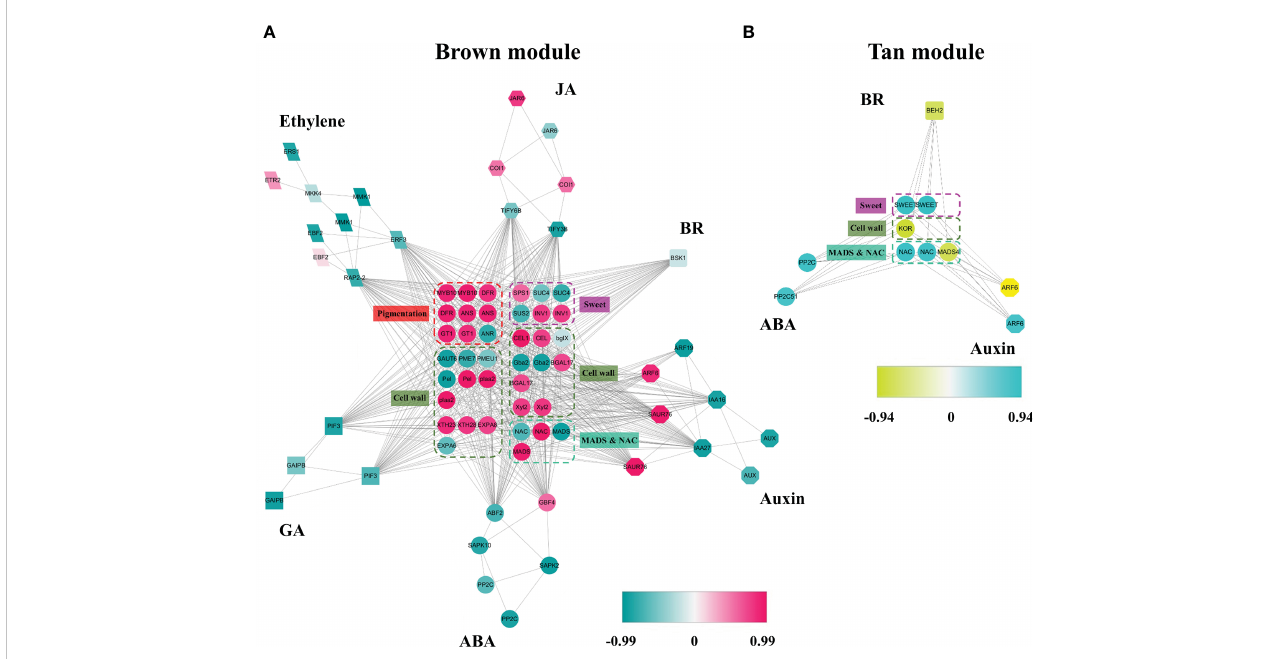
FIGURE 3 Coexpression networks of ABA and other phytohormone signaling pathways during receptacle ripening, in brown and red modules. (A) The coexpression network in the red module is positively related to ripening based on WGCNA. Each of shaped block present an isoform, and the colors denote a positively or negatively relationship with the module as indicated by the scale bar. If more than two isoforms of a gene were detected in the module, only the isoforms with highest and lowest levels of correlation with the module are shown. In the fi gure, the isoforms associated with phytohormone signaling revolve around the isoforms involved in quality traits, such as pigmentation, softening, and sweetness, as well as TFs including MADS and NAC genes related to ripening. (B) The coexpression network in the tan module positively related to ripening. JA, jasmonic acid; BR, brassinosteroid; GA, gibberellins. The full names of the abbreviations of the isoforms are shown in Supplementary Dataset